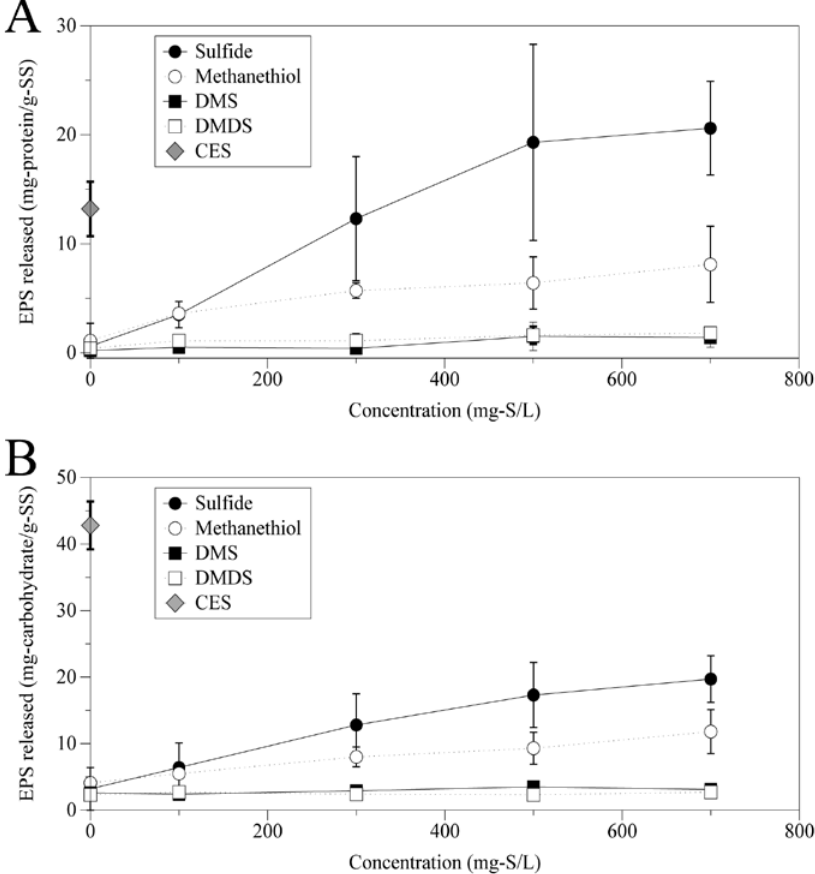
Figure 2. Protein ( A ) and carbohydrate ( B ) released from the granules at different concentrations of sulfur